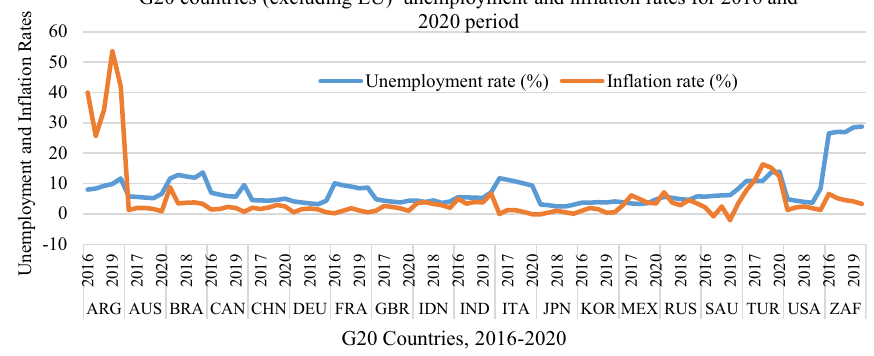
Fig. 7 G20 countries unemployment and inflation rates for 2016 to 2020